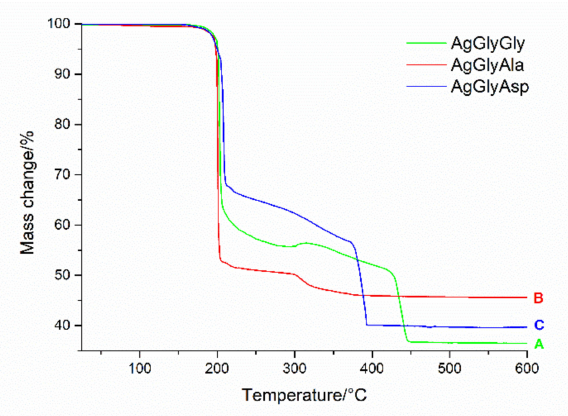
Figure 2. Thermogravimetric curves for studied silver(I) complexes measured in the air atmosphere in the temperature range of 25–600 ◦